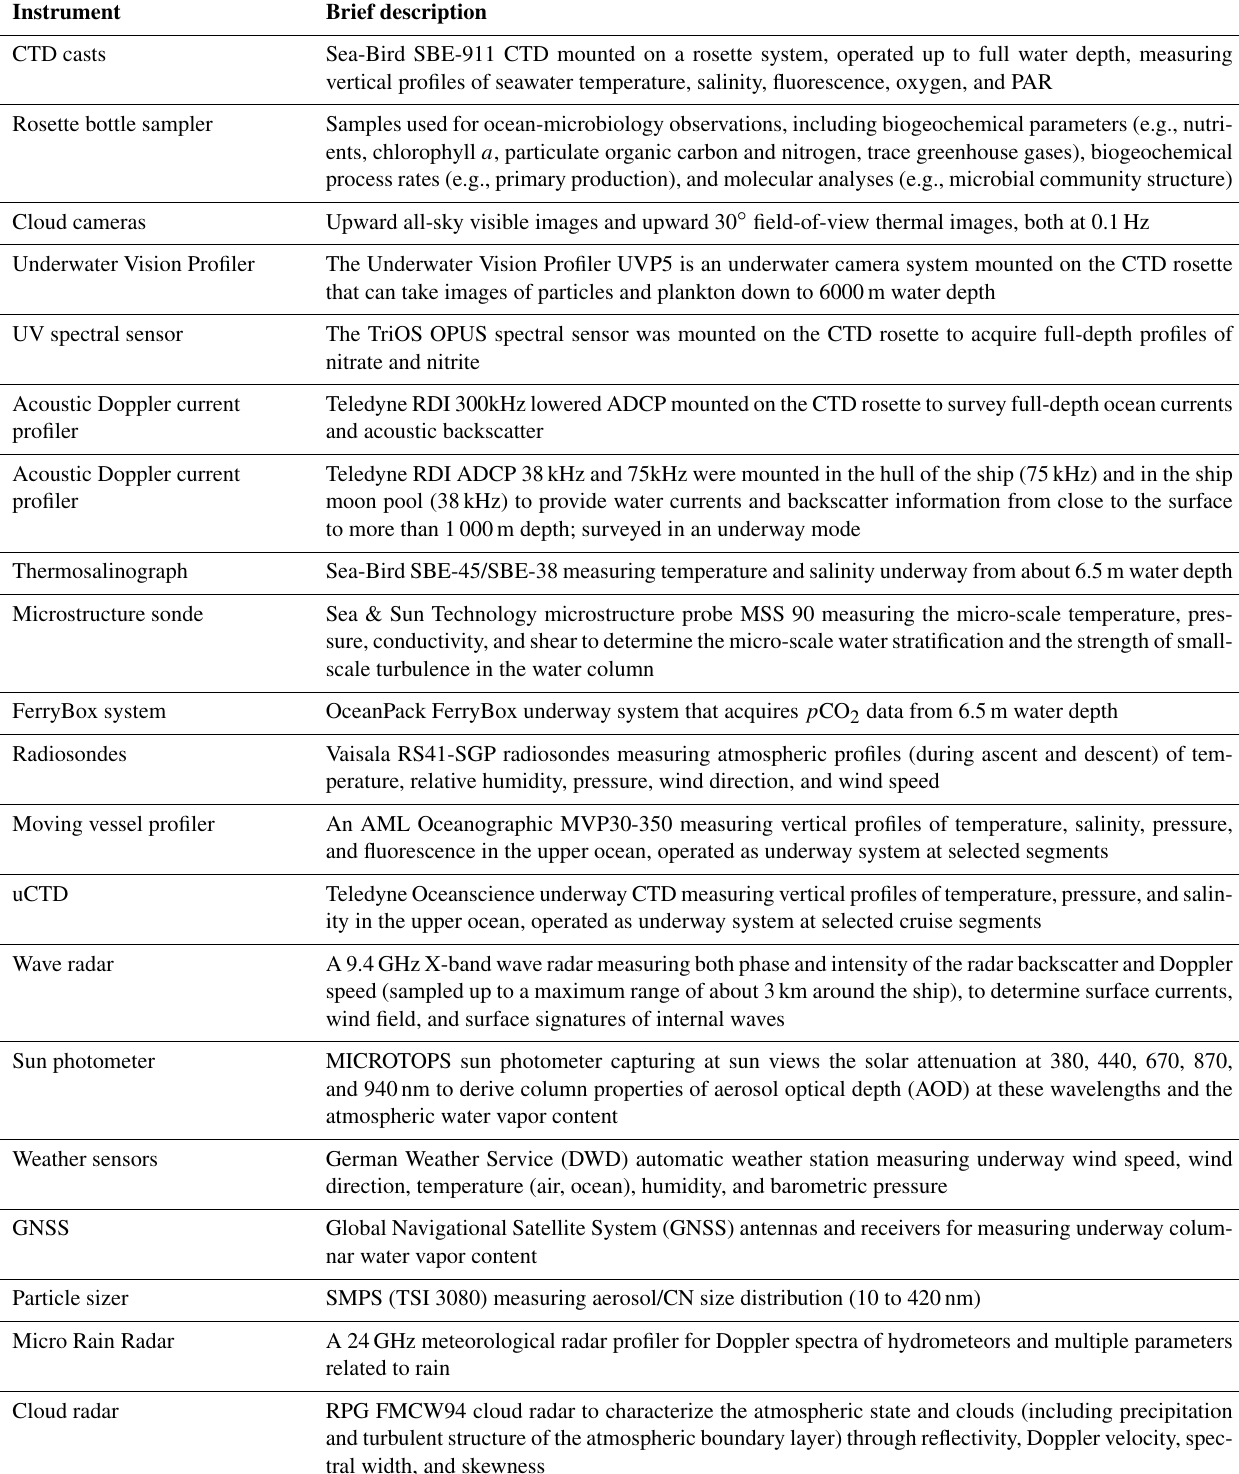
Table B8. MS-Merian .